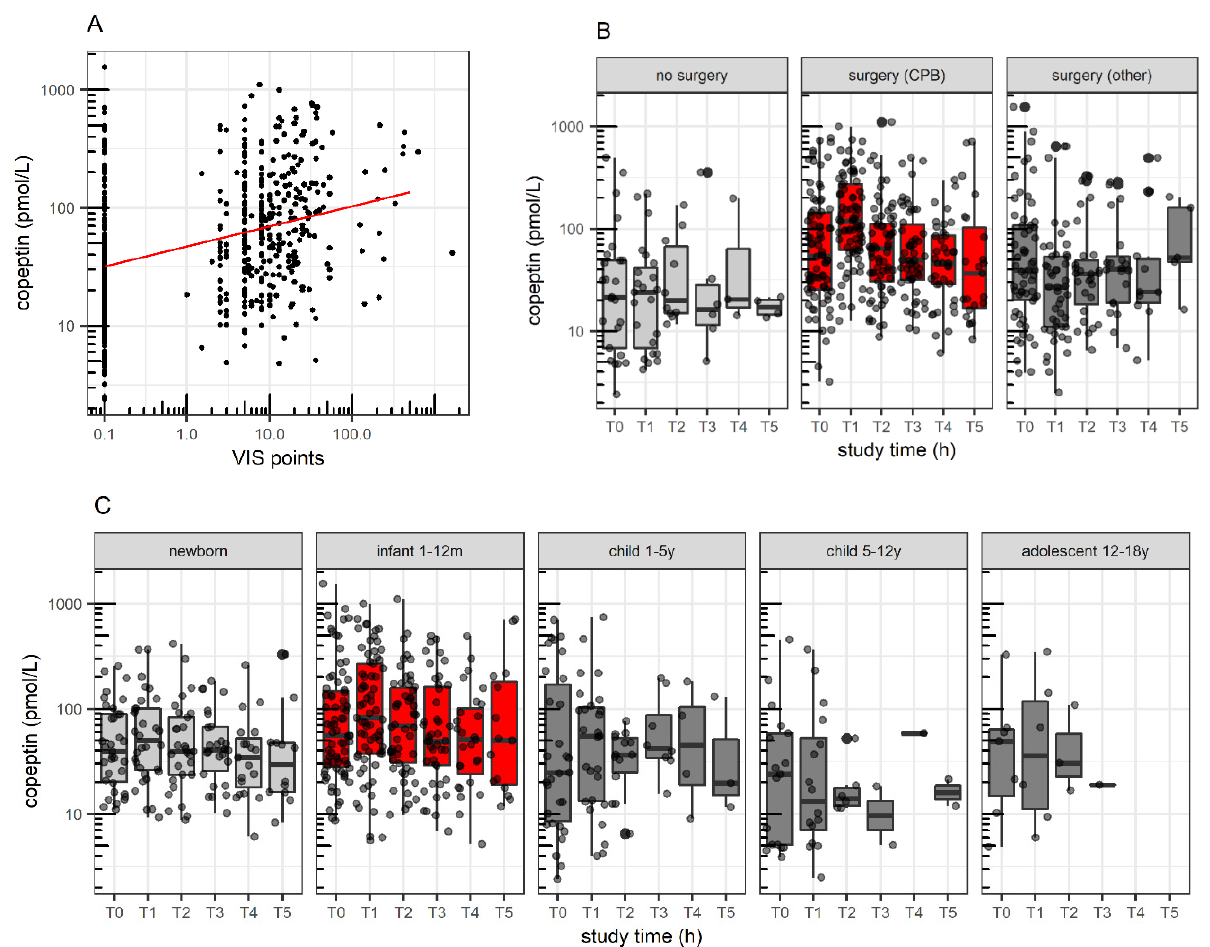
Figure 3. Blood copeptin levels stratified by variables that remained significantly associated in the adjusted mixed-effect regression. ( A ) Blood copeptin levels versus vasopressor-inotrope treatment (VIS points on log-scale, VIS = 0 is plotted at 0.1). ( B ) Blood copeptin levels over the study period stratified by surgery, red boxes = copeptin levels in patients after cardiopulmonary bypass (CPB) surgery were significantly higher than in patients without surgery (=reference). ( C ) Blood copeptin levels over the study period stratified by age, red boxes = copeptin levels in infants 1–12 month of age were significantly higher than in neonates (=reference). Boxes represent the interquartile range (IQR). Solid lines are the median, 25th and 75th quantile, and whiskers equal to 25th quantile − 1.5 IQR and 75th quantile +1.5 IQR. Corresponding time points: T0 = study start/T1 = 14 h (median, interquartile range (11–16 h))/T2 = 37 h (34–40 h)/T3 = 61 h (58–63 h)/T4 = 108 h (97–110 h)/T5 = 179 h (168–182 h).